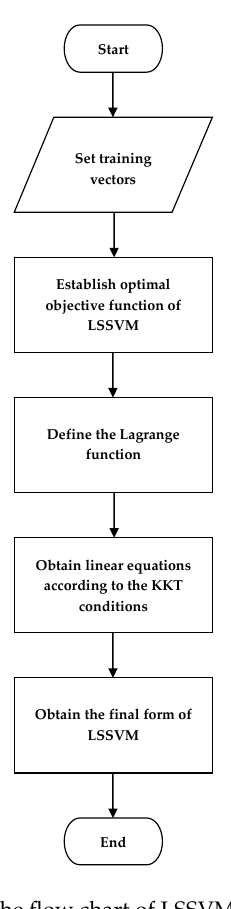
Figure 1. The flow chart of LSSVM principle.